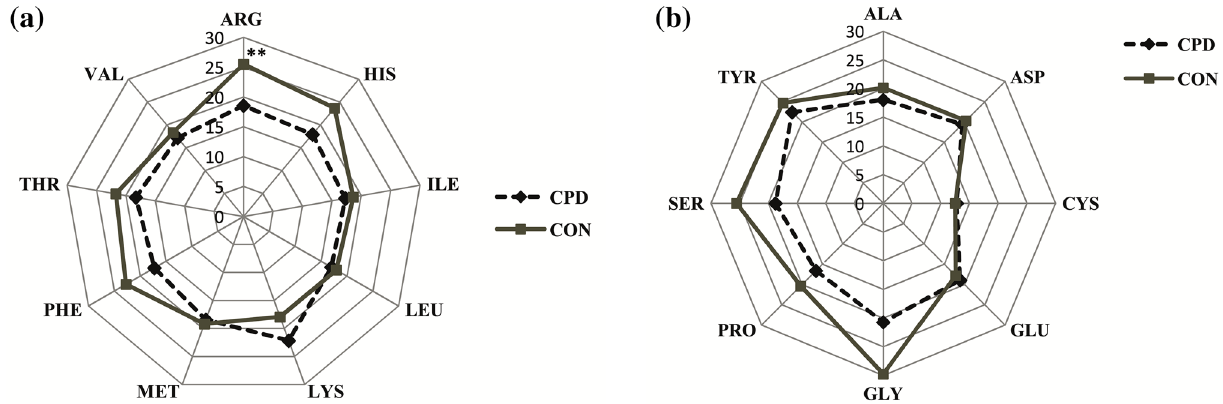
Fig. 2 a Indispensable amino acid (IAA) retention of sharpsnout sea- bream fed with CON and CPD. Values are ± SD of three replications. Data with double asterisk differ at P < 0.01. b Dispensable amino acid